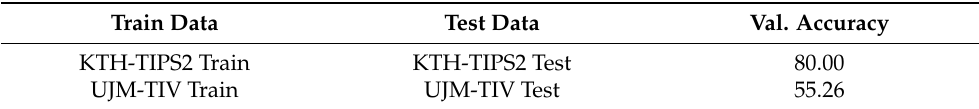
Table 3. Model accuracy of single branch network with KTH-TIPS2 and UJM-TIV when considering all the